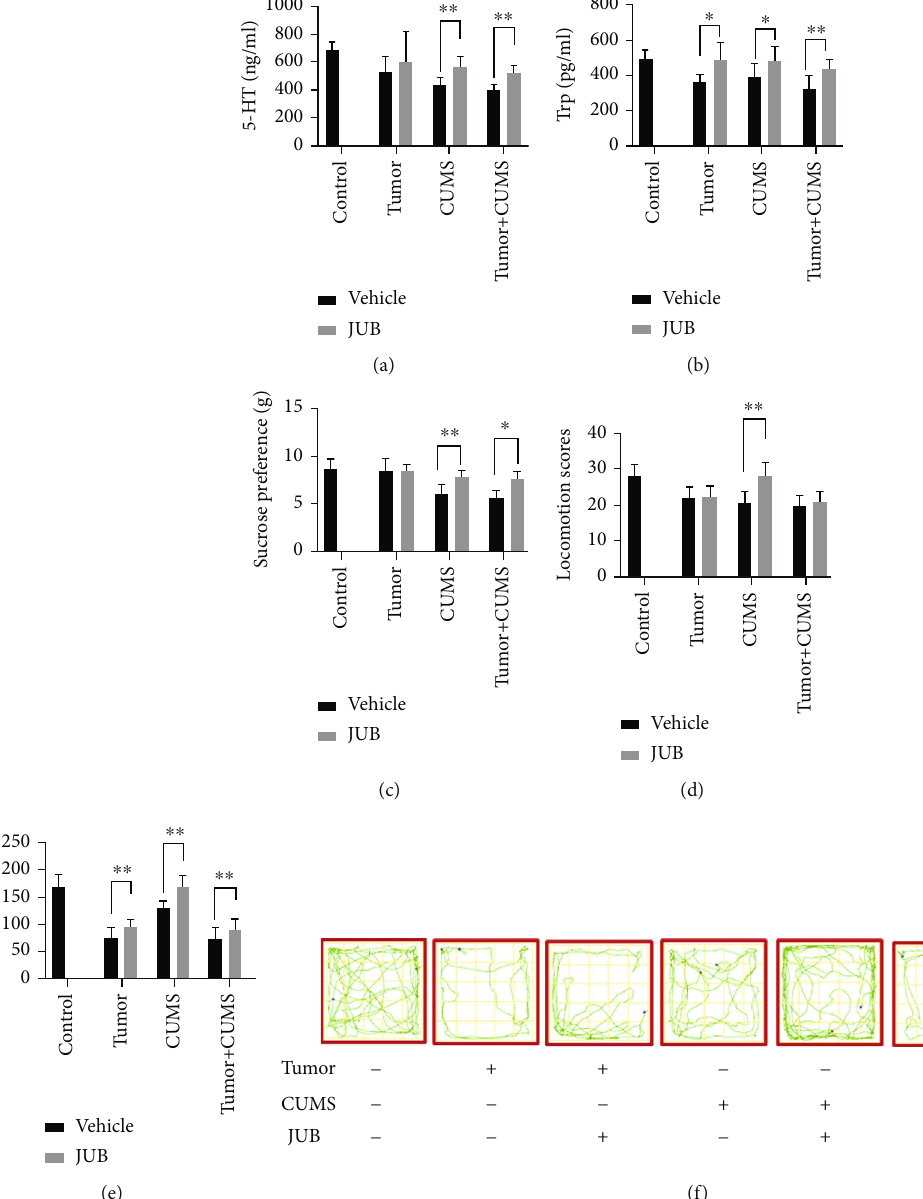
Figure 3: JUB ameliorated the depression-like behavior. Biochemical tests (a – b), sucrose preference (c), locomotion scores, and exploratory scores (d – e) before and after JUB (40 mg/kg/day) or vehicle administration for 2 weeks. (f) Movement of open- fi eld test. Data are mean ± SD ( n = 8/group ). ∗ P < 0 : 05and ∗∗ P < 0 : 01